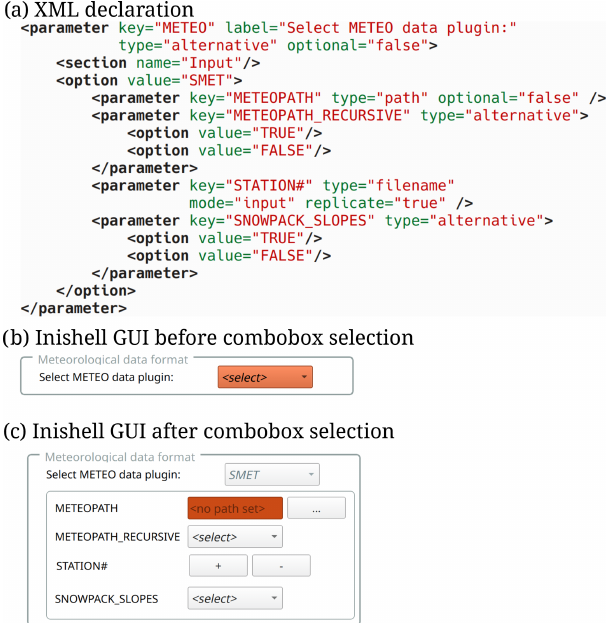
Figure 9. Example of nested widgets (panels a , b , and c are similar to those of Fig. 6; for clarity, the help texts have been